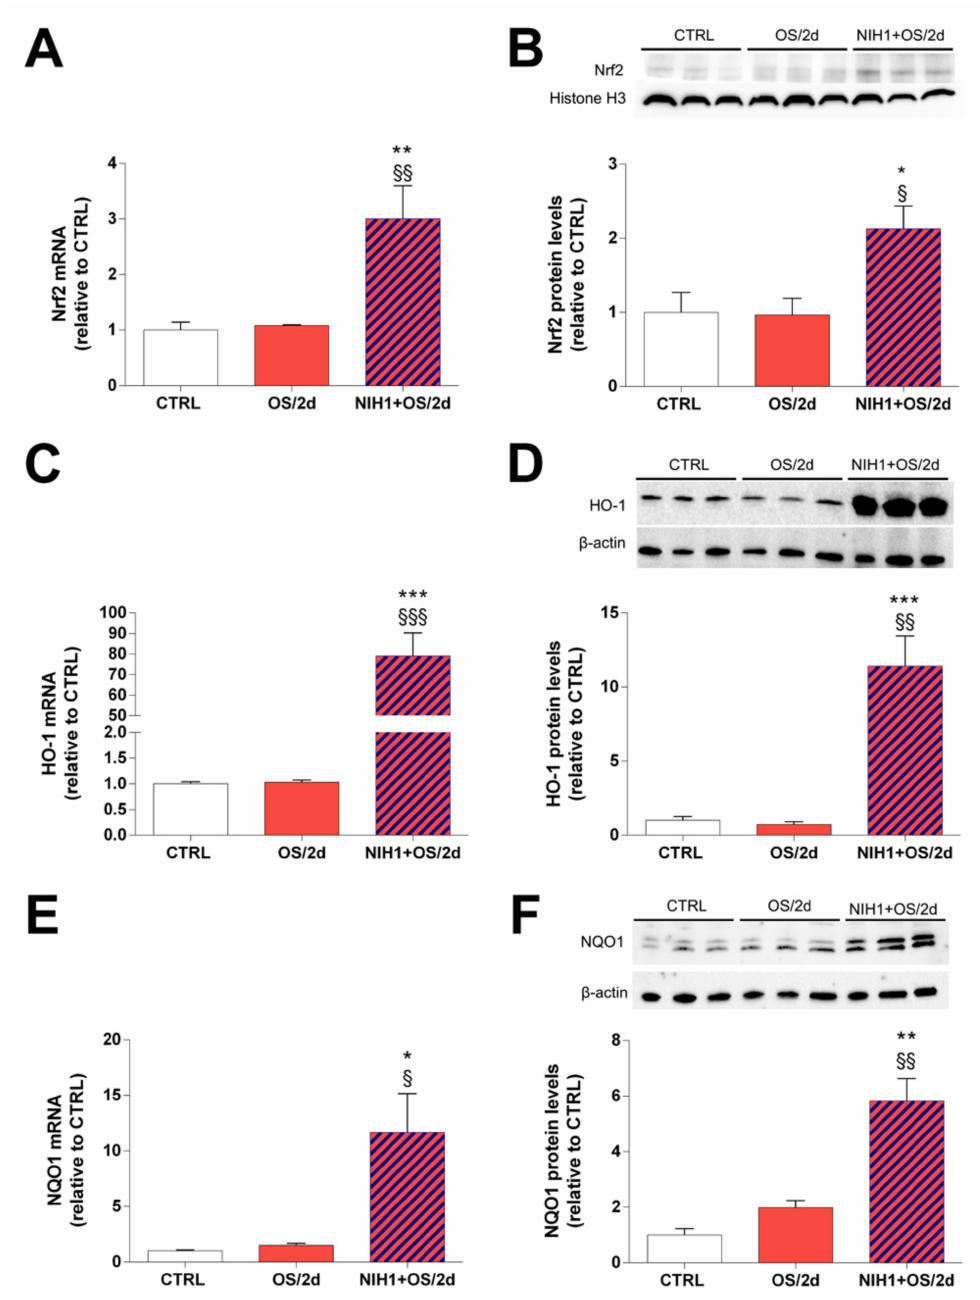
Figure 5. Short-term antioxidant effect of NIH1 in retinal explants treated with NIH1 for two days. The mRNA levels of ( A ) Nrf2, ( C ) HO-1, and ( E ) NQO-1 were evaluated with qPCR in CTRL explants, in retinal explants treated with OS for two days (OS/2d), and in retinal explants treated with OS together with NIH1 for two days (NIH1 + OS/2d). ( B ) Western blot analysis of nuclear protein fraction showing representative immunoreactive bands and quantitative densitometric analysis of the Nrf2 protein levels in CTRL, OS/2d and NIH1 + OS/2d explants. ( D , F ) Western blot analysis of total protein fraction showing representative immunoreactive bands and quantitative densitometric analysis of the HO-1 and NQO1 protein levels in CTRL, OS/2d and NIH1 + OS/2d explants. One- way ANOVA, n = 3; * p < 0.05, ** p < 0.01, *** p < 0.001 vs. CTRL; § p < 0.05, §§ p < 0.01, §§§ p < 0.001 vs.